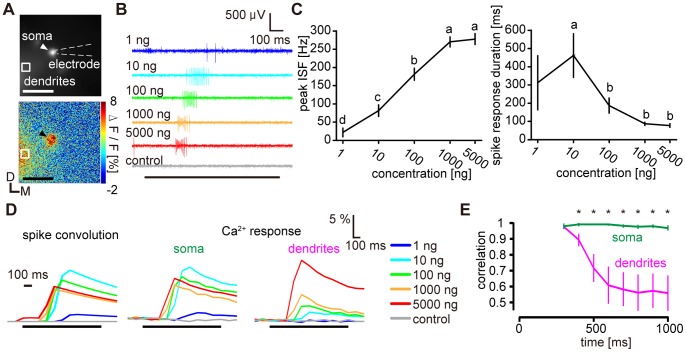
Relation between calcium and spike responses in PNs.
A, Fluorescence images of PNs labeled with calcium indicator (top) and the response to 1000 ng bombykol in false colors (bottom). Spike responses were recorded from the labeled soma indicated by the arrowhead. The microelectrode for loose-patch recording is delineated by dashed lines and the ROI in the dendritic region is marked. D: dorsal, M: medial. Scale bars: 50 µm. B, Representative PN spike responses to bombykol stimuli. The responses were recorded from the soma shown in (A). Black bar under the spike responses indicates stimulus. C, Concentration-response characteristics of PN spike responses. The response amplitudes were quantified using peak instantaneous spike frequency (peak ISF, left) and spike response duration (right). (P<0.05 for significant differences indicated by different letters associated with the data groups shown as means±SEM, n = 6, one-way repeated measures ANOVA followed by Tukey-Kramer test). D, Representative time courses of convoluted PN spike responses (left) and simultaneously acquired calcium responses in the soma (middle) and the dendrites (right). Same sample as shown in (A) and (B). E, Time courses of correlation coefficients between PN spike convolutions and calcium responses in the dendrites (magenta), and between the spike convolutions and calcium responses of the somata (green) (*: P<0.05 between both correlation coefficients at each time point, n = 6, Wilcoxon signed-rank test, data shown as means±SEM). For the first 200 ms following stimulus onset, correlation coefficients are not available because spike responses had a longer latency for all stimulus concentrations.